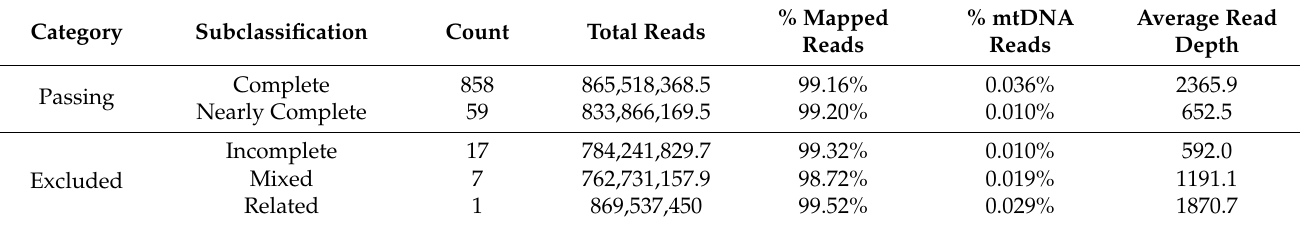
Table 1. Average analysis metrics for each sample category based on the mitochondrial DNA (mtDNA) analysis of the SweGen dataset. The passing category includes complete (all positions with at least 100X read depth) and nearly complete (one to four positions below 100X) haplotypes that met all quality control criteria. Incomplete haplotypes (five or more positions below 100X), possible mixtures and related samples were excluded from the analysis. The “% Mapped Reads” is the proportion of total reads that mapped to the GRCh37 and the “% mtDNA Reads” is the proportion of the mapped reads that aligned to the mtDNA reference